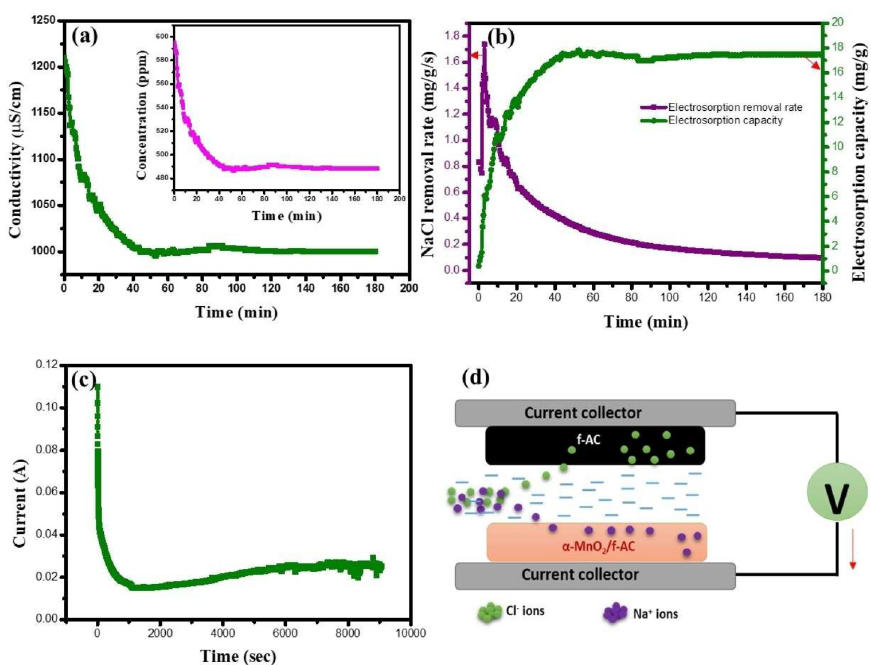
Figure 21. ( a ) Capacitive deionization (CDI) profile for solution conductivity vs. time (inset Figure concentration (ppm) vs. time (min)), ( b ) electrosorption rate and electrosorption capacity of prepared electrodes, ( c ) current response of the prepared electrodes during desalination performances, and ( d ) schematic illustration of the CDI hybrid system. Reprinted from [43], ©2020 The Authors. Table 2. Comparison of the specific capacitance and electrosorption capacity of different CDI elec- trodes. Adopted with permission from [43], ©2020 The Authors.